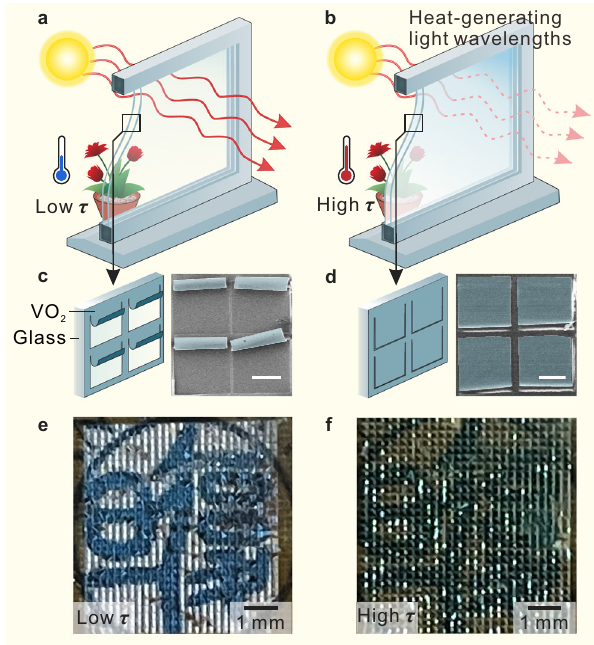
Fig. 1 | Mechanism of rolled-up SW for intelligent light control. a Schematic of rolled-up SW for high transparency at low temperatures (low τ ). b Schematic of rolled-up SW for blocking sunlight at high temperatures (high τ ). c Structure of rolled-upSWandcorrespondingthescanningelectronmicroscopy(SEM)imageat low τ . Scaler bar: 100 μ m. d Structure of rolled-up SW and corresponding the SEM image at high τ . Scaler bar: 100 μ m. e Photograph of rolled-up SW at low τ . f Photograph of rolled-up SW at high τ